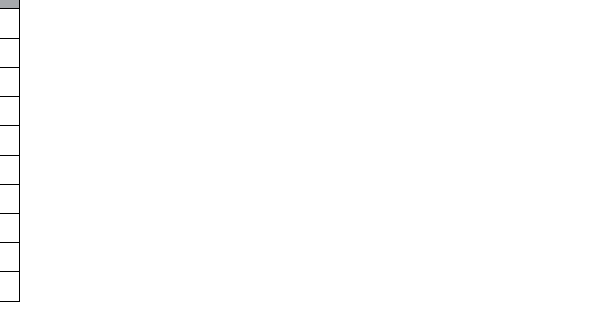
Table 2. Statistics of flowerpot wall